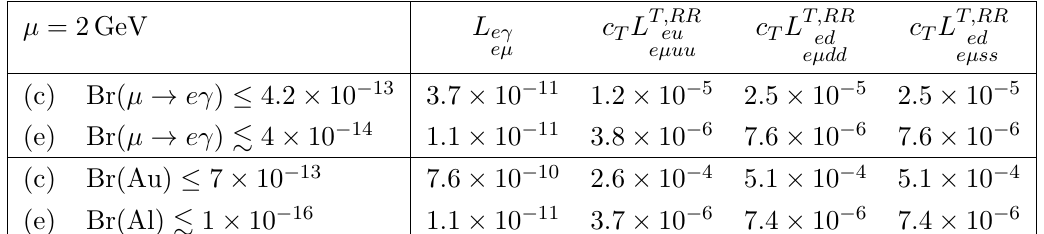
Table 2 . Current (c) and expected (e) limits from (cid:22) ! e(cid:13) and (cid:22) ! e conversion experiments on the coe(cid:14)cients of the dipole and tensor operators at the scale (cid:22) = 2 GeV. The limits are given in units of TeV (cid:0) 2 for the tensor operators, while those for L e(cid:13) the absolute values of both the listed coe(cid:14)cients as well as the coe(cid:14)cients L e(cid:13)